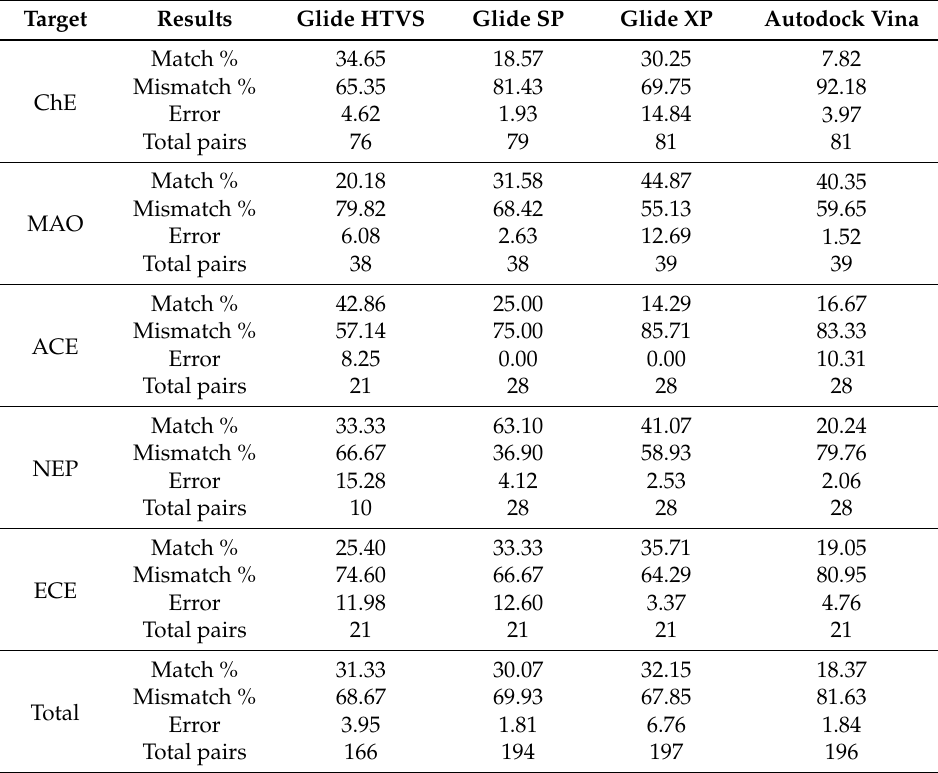
Table 2. Percentages of match and mismatch for the categories E , D H , or D L , when comparing C A and C P for M W pairs.